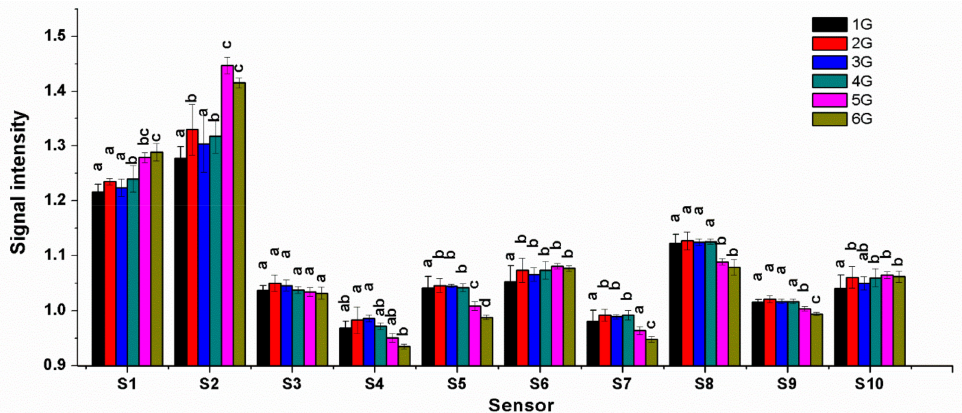
Figure 3. Response values of ten sensors to volatile compounds from di ff erent grades of jasmine tea samples. *Note: The bar marked with the same letter ( a , b , c ), within a sensor, are not significantly di ff erent between two grade samples ( p >